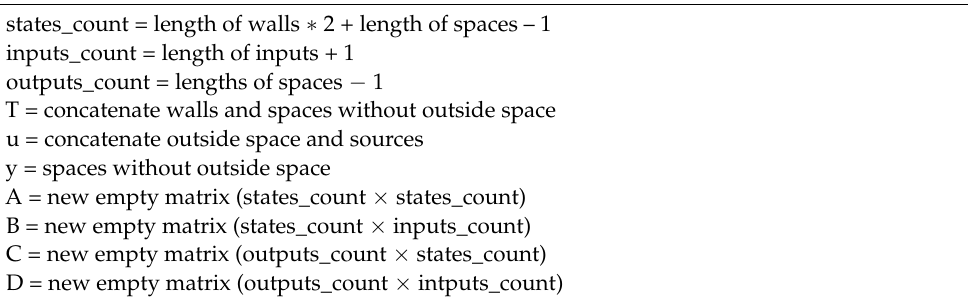
Algorithm 1. The definition of the number of states, inputs and outputs and their vectors and matrices (pseudo-code representation)